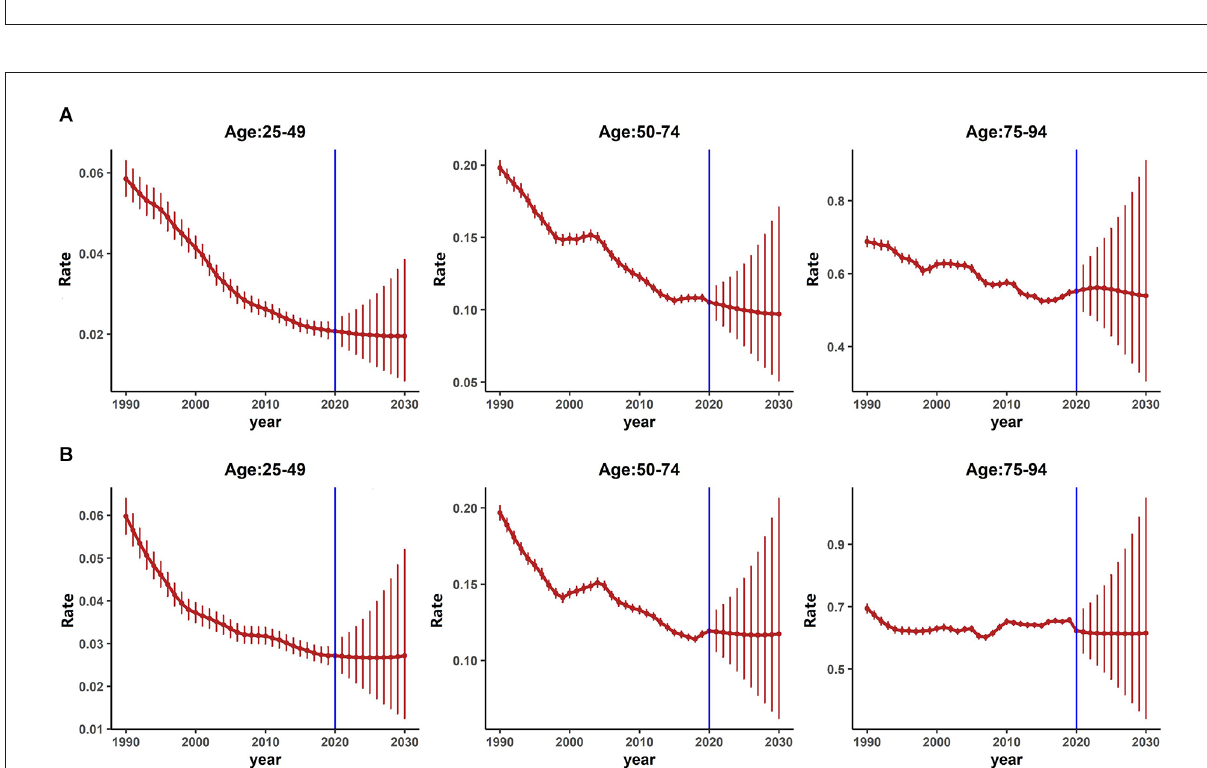
FIGURE4 Projected age-specific mortality of PD from 2020 to 2030 by gender. (A) Projected age-specific PD mortality for females. (B) Projected age-specific PD mortality for males.